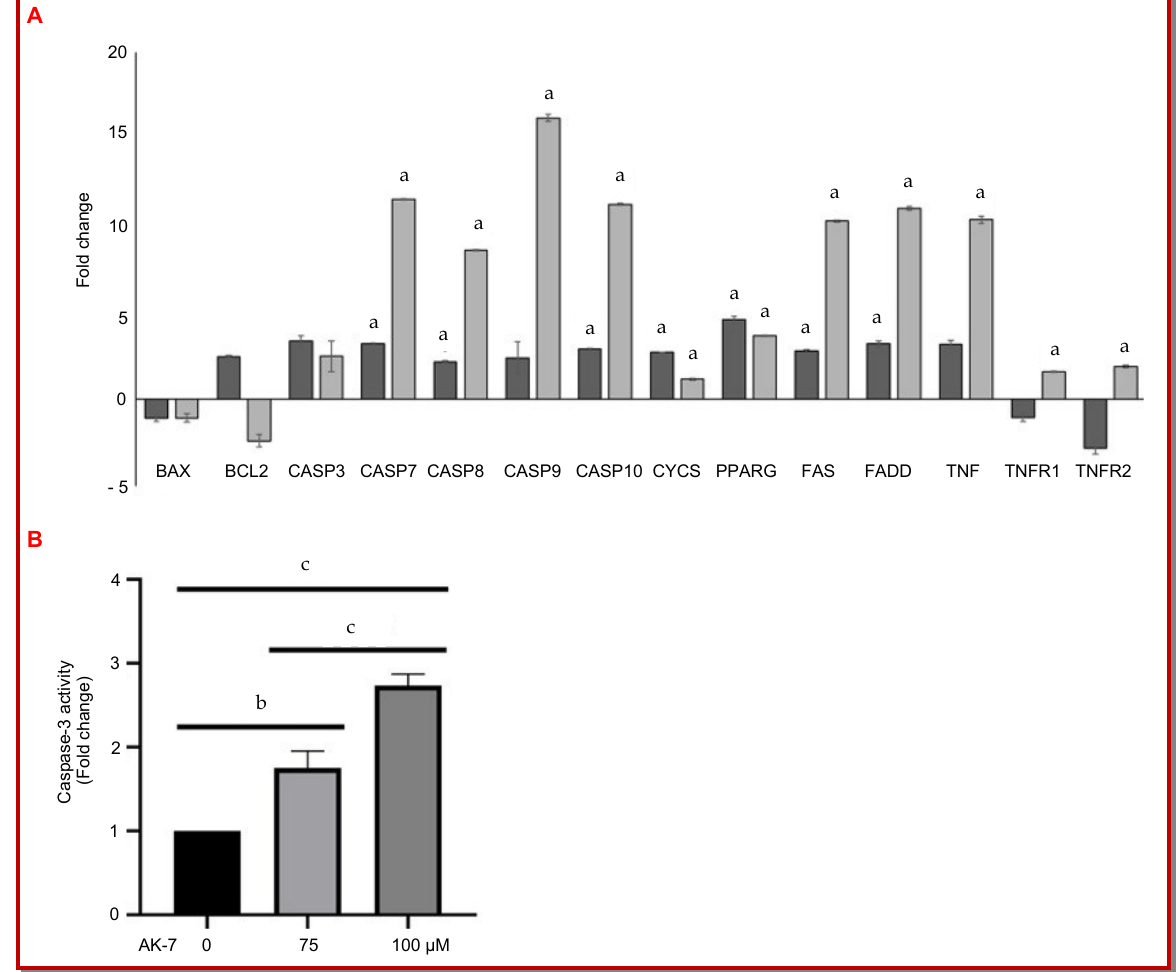
Figure 3: Effect of AK-7 on caspase pathway mediated apoptosis in U87 GBM cells. After treatment with AK-7 (75 and 100 µM) for 48 hours, mRNA expression levels of apoptosis-associated genes were analyzed by qRT-PCR (A). The effects of two different con- centrations of AK-7 compared to the control group on caspase-3 activity were performed using the caspase-3 assay kit ( a p<0.05, b p<0.01, c p<0.001)